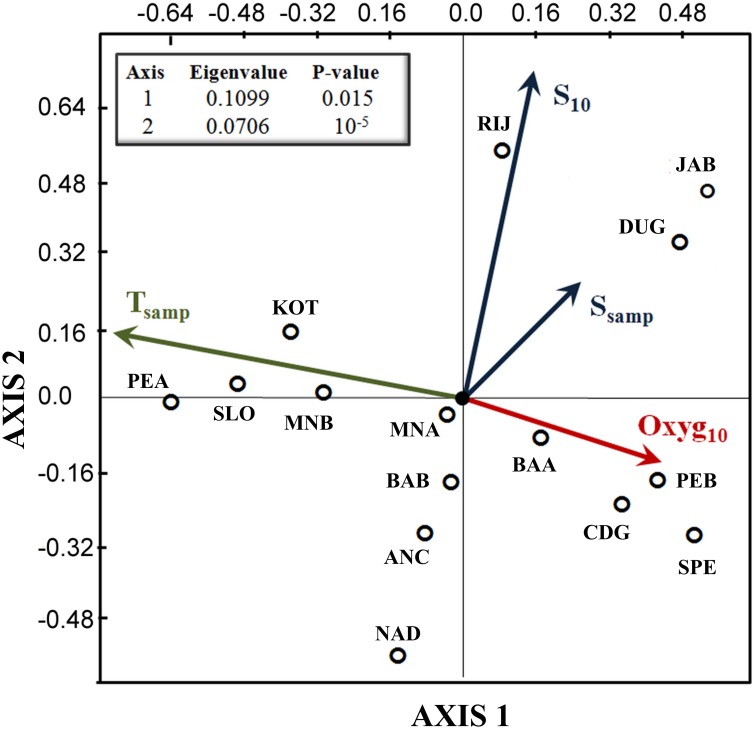
Canonical Correspondence Analysis (CCA) of microsatellites and environmental variability.The plot shows the distribution of samples with candidate outlier loci that were correlated with the four environmental variables, Tsamp, S10, Ssamp, Oxyg10. Arrows identify the four environmental variables and their direction explain which samples are most correlated with them.